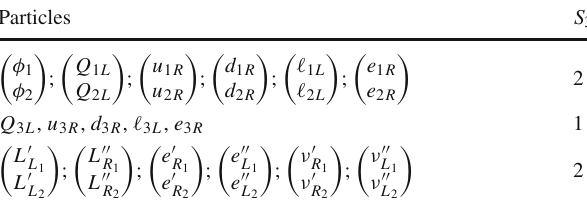
Table 2 S 3 quantum number assigned to the particles in the model